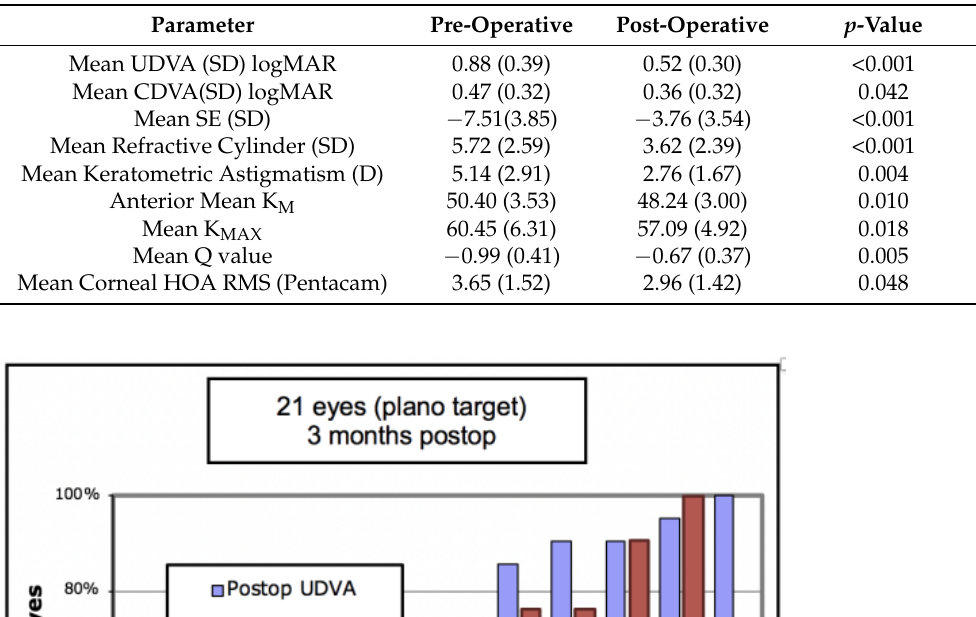
Table 2. Visual, refractive, and tomographic outcomes of 21 keratoconic eyes implanted with Ferrara intrastromal corneal ring segments.